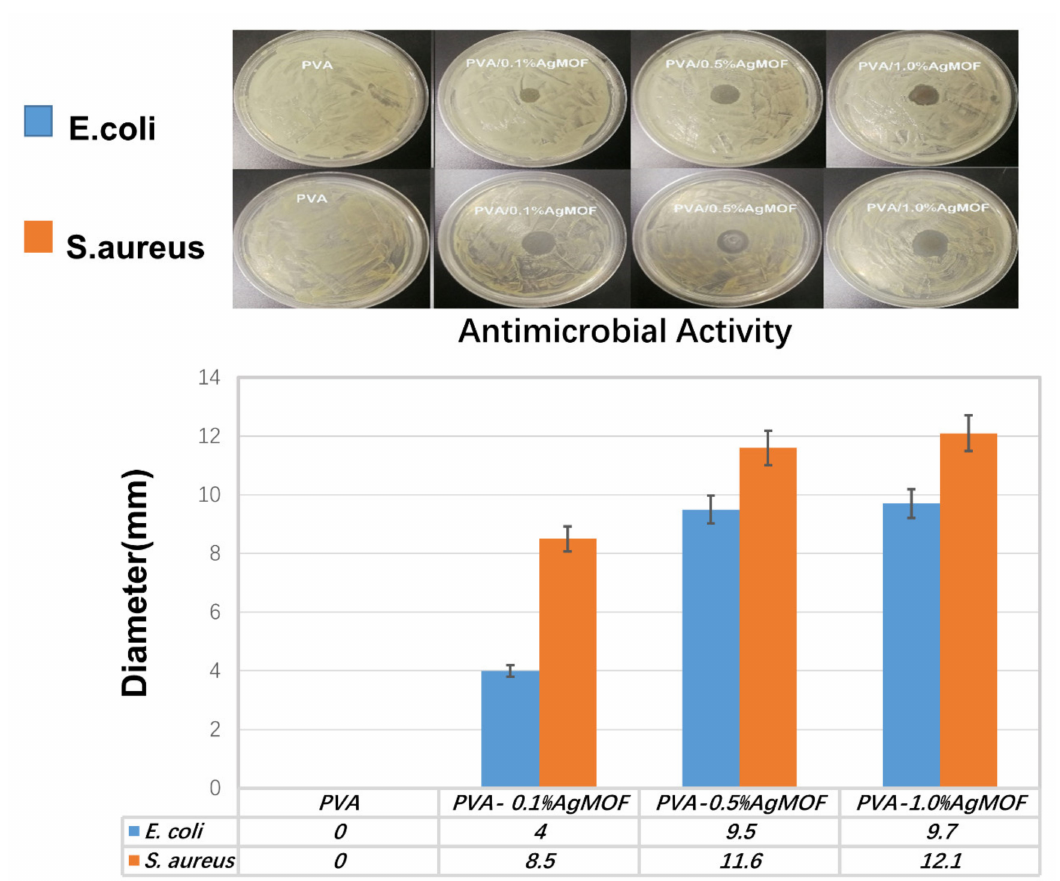
Figure 6. Images and diameters of inhibition zones for PVA and PVA/Ag@MOF hydrogels against E. coli and S. aureus